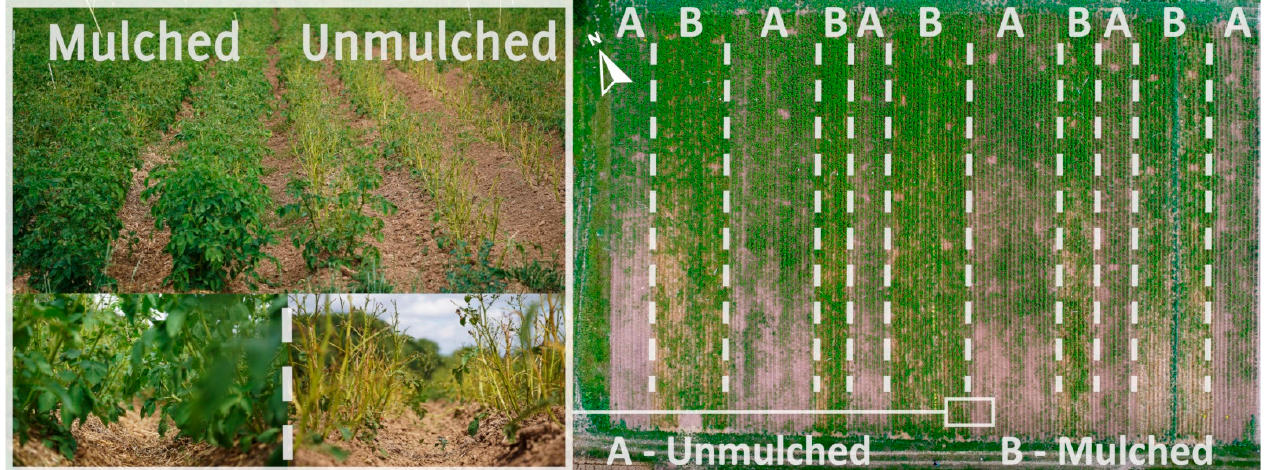
Figure 4. Comparison of unmulched and triticale-vetch mulched potatoes on 9 July 2018. Left: Skeletonized leaf damage in unmulched potatoes before flowering. Right: Initial infestation started in the south-west exposed plots resulting in a distinct gradient from the edge of the field (Figure modified according to [9]).